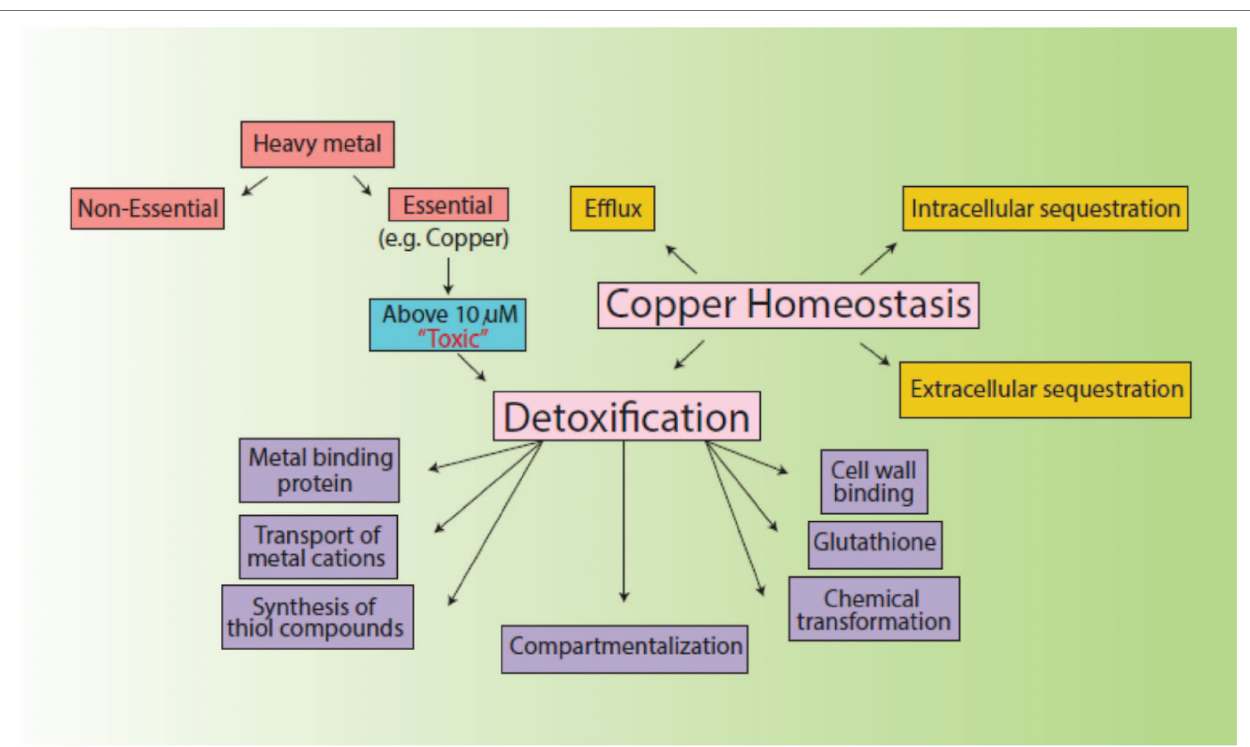
FIGURE 11 | Mechanisms of copper homeostasis and